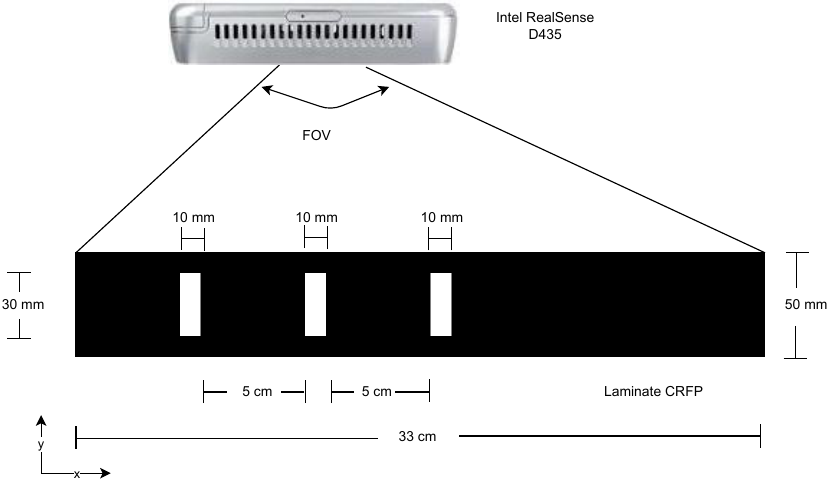
Figure 4. Set up for image acquisition.